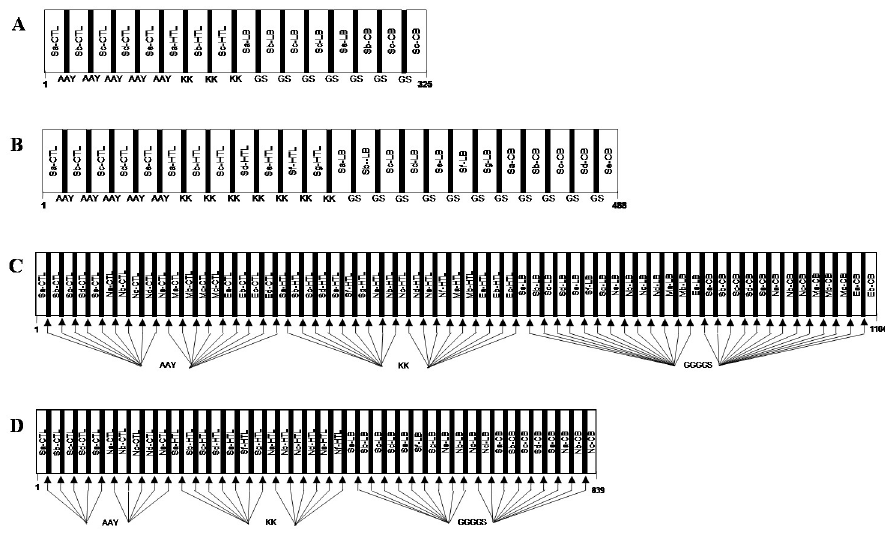
Fig 6. Schematic diagram of multi-epitope vaccine constructs of SARS-CoV-2. The multi-epitope vaccine constructs consisted of top-ranked predicted and experimentally validated B- and T-cell epitopes. Cytotoxic T lymphocytes (CTL) epitopes were joined by the AAY linker, whereas helper T lymphocytes (HTL) and B-cell epitopes were joined by KK and GGGGS linkers, respectively. (a) The receptor-binding domain (RBD) of the spike (S) protein (B- and T-cell epitopes); (b) The S protein (B- and T-cell epitopes), (c) The structural protein construct (B- and T-cell epitopes of S, N, M, and E proteins); (d) The chimeric construct of S and N proteins (B- and T-cell epitopes of S and N